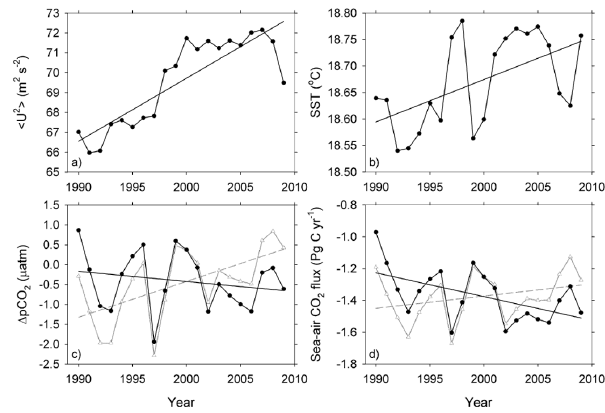
Fig. 10. 20yr global ocean trends in: (a) second moment of wind speed; (b) SST; (c) 1p CO 2 , assuming no atmospheric CO 2 in- crease (gray line) and including atmospheric CO 2 forcing (black line); and (d) globally integrated contemporary sea–air CO 2 flux over the past two decades (1990–2009) without atmospheric CO 2 forcing (gray line) and including atmospheric CO 2 forcing (black line). The change in 1p CO 2 is determined according to the pro- cedures of Park et al. (2010a). The slopes for the linear regres- sions (solid line) for area-weighted <U 2 > , SST, 1p CO 2 and flux are 0.32 ± 0.04 (ms − 1 ) 2 yr − 1 ; 0.08 ± 0.03 ( ◦ Cyr − 1 ) decade − 1 ; − 0.3 ± 0.3 (µatm yr − 1 ) decade − 1 including atmospheric CO ing; and − 0.15 ± 0.06 (PgCyr − 1 ) decade − 1 including atmospheric CO 2 forcing,